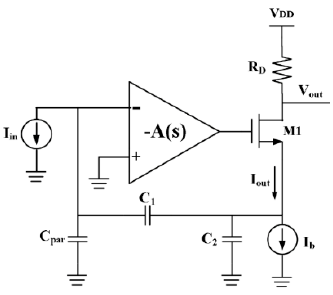
Figure 30. Capacitive sustaining amplifier circuit [254]. © 2014 IEEE. Reprinted with permission from CMOS 0.18 µm standard process capacitive MEMS high-Q oscillator with ultra low-power TIA readout system by Kuo in Proceedings of the IEEE Sensors, 2014.